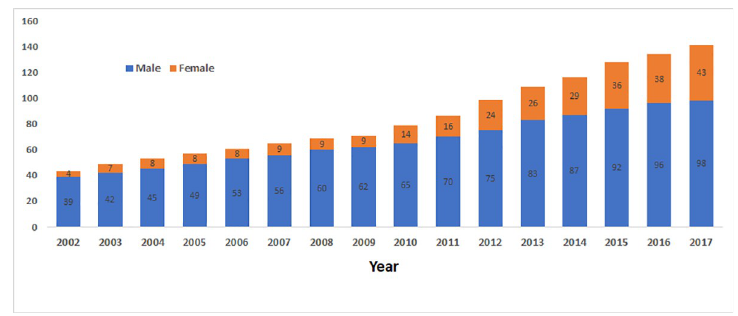
Fig 1. Trends in the number and sex distribution of nephrologists, 2002 to